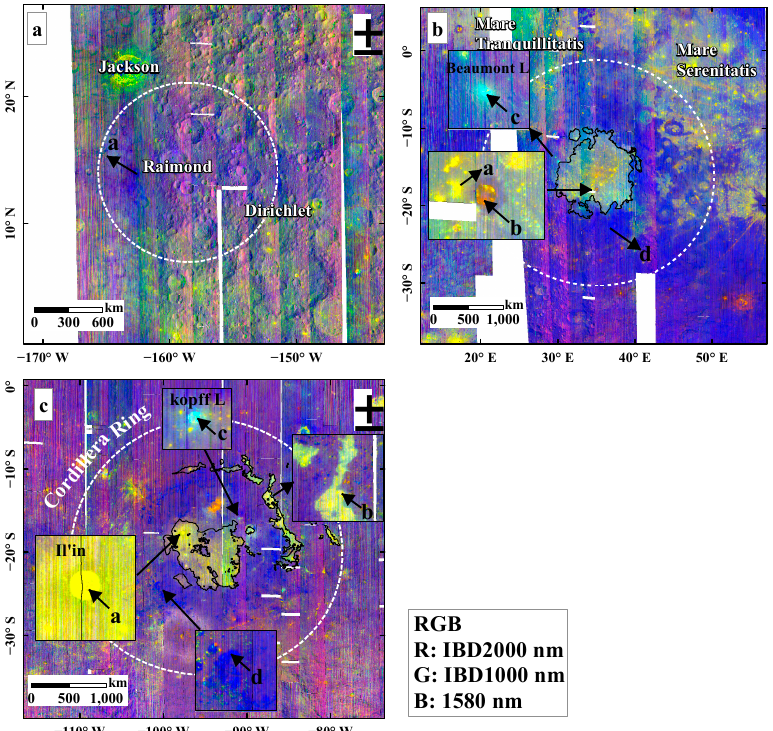
Figure 12. Composite map of the spectral parameters of the Dirichlet–Jackson Basin ( a ), Nectaris Basin ( b ), and Orientale Basin ( c ) calculated from the M3 data. The white dotted lines show the main rings of the basins. The blue color of the Dirichlet–Jackson Basin region in the composite spectral param- eter map (e.g., point a in Figure 12a) indicates that the region is dominated by plagioclase, which likely corresponds to the lunar crust composition before the formation of the basin. The Nectaris mare regions and the surrounding highlands exhibit clear differences on the IBD map. The materials in Mare Nectaris near the Rosse crater (e.g., point a in Figure 12b) display strong absorptions at both 1000 nm and 2250 nm (Figure 13a), indicating that the regolith in this area contains fresh pyroxene materials. At the wall of the Rosse crater (e.g., point b in Figure 12b), the materials show relatively weak absorption characteristics at 1000 nm and 2250 nm (Figure 13b). The Mare Nectaris appears yellow-orange, display- ing absorption characteristics at 1000 nm and 2000 nm indicating a mainly pyroxene com- position. The materials in the southern wall of the Beaumont L crater (e.g., point c in Fig- ure 12b) display an absorption band at 1000 nm but no absorption band at 2250 nm (Figure 13c), indicating that the minerals are olivine-rich. Additionally, the materials in the sur- rounding highlands at the composite map (point d in Figure 12b) are blue, indicating feld- spathic materials (Figure 13d).